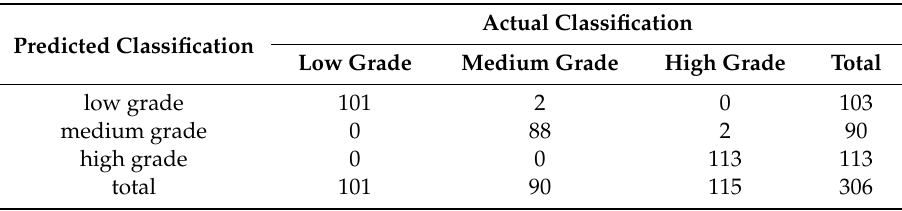
Table 3. Three categories of the classification confusion matrix.